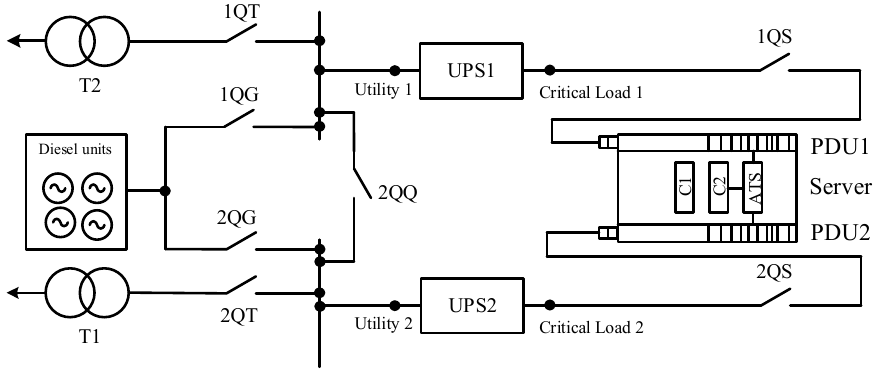
Figure 2. The data center PSS.